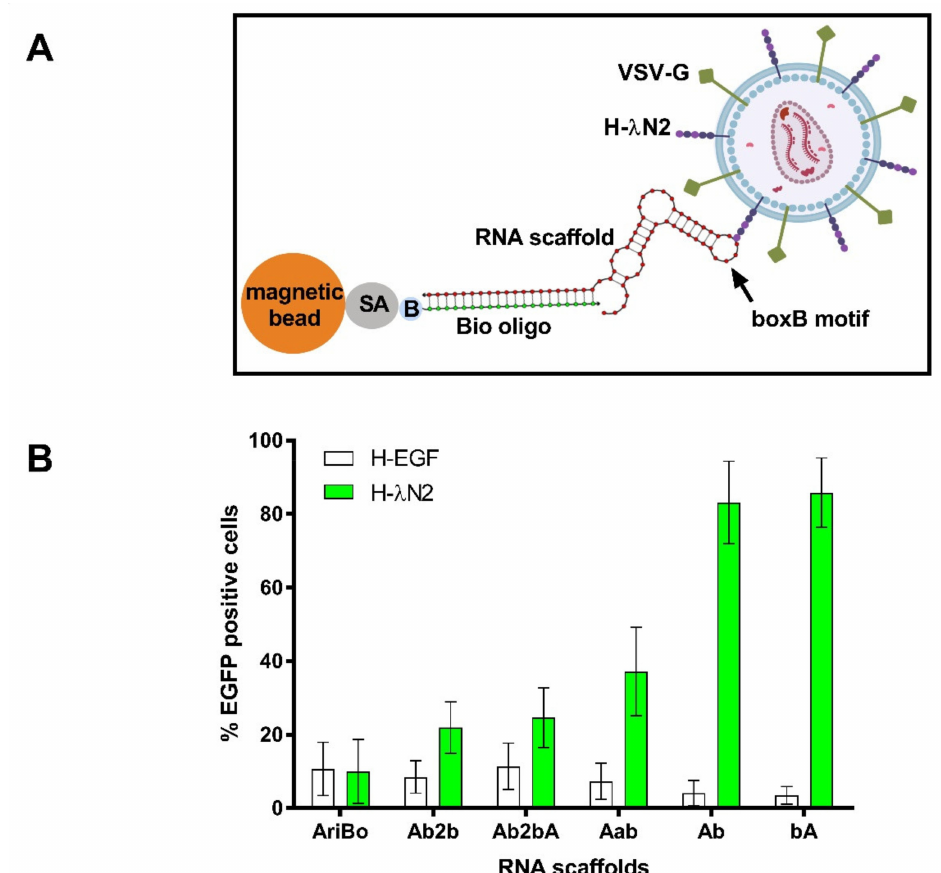
Figure 2. Testing of RNA scaffold binding to the H- λ N2 protein displayed on lentiviral vector particles. ( A ) Outline of the approach to test the scaffold binding to the LV vector particles displaying the H- λ N2 plus VSV-G proteins. The vectors containing H-EGF instead of H- λ N2 were used as a control. The vectors were exposed to RNA scaffolds immobilized on streptavidin-coated magnetic beads via the Bio oligo. ( B ) To determine the transduction efficiencies, magnetic beads with LV vector particles attached were added to A431 cells and the percentage of EGFP-positive cells was determined by using flow cytometry three days later. The error bars represent the means ± SD of three independent